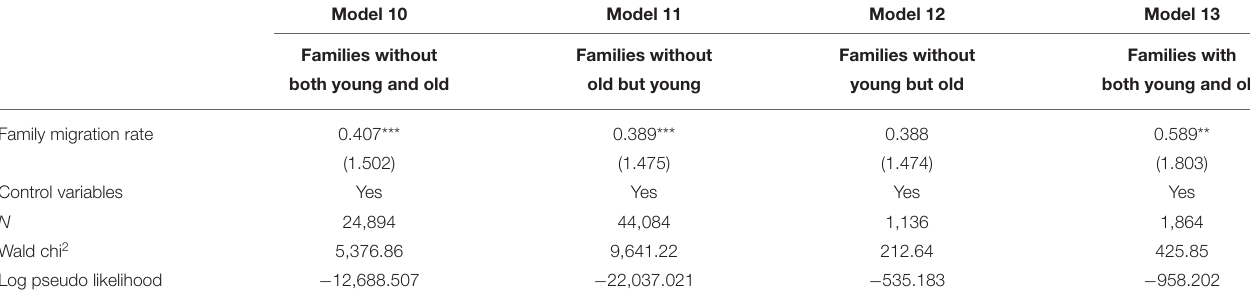
TABLE 8 | Effect of family migration rate on health care participation by family